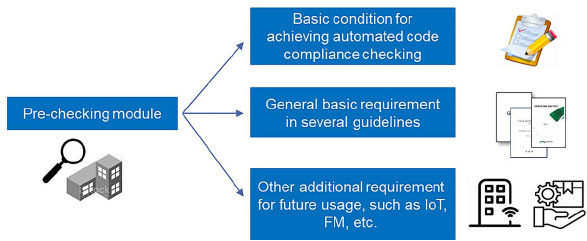
Figure 3. Pre-checking module for modular BIM